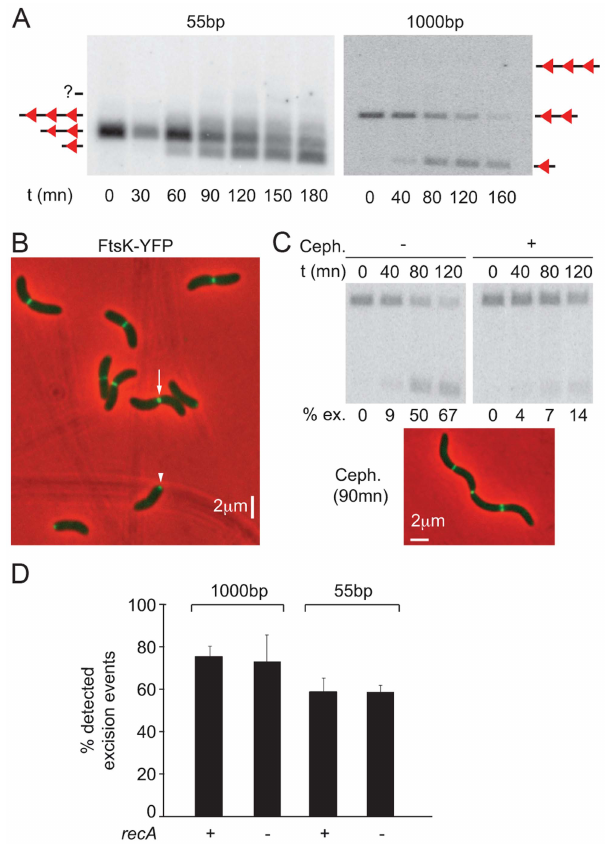
Figure 3. Control of dif -recombination. A. Structural control of Xer recombination. Southern blot showing the different recombination products obtained with 55 bp- and 1 kbp- cassettes inserted at the dif1 locus. B. FtsK-YFP localization. The white arrow indicates a cell in which FtsK is located at the septum; the white arrowhead shows a cell in which FtsK is located at the new pole. C. Temporal control of Xer recombination. Upper panels: southern blot showing the excision of a 1 kbp cassette inserted at the dif1 locus, without or with cephalexin treatment. t: time of the experiment; ex.: excision frequency. Lower panel: snapshot showing that cephalexin treatment results in filamen- tation but does not prevent FtsK localization to mid-cell. D. RecA- independent recombination between dif2 sites inserted at the dif1 locus.